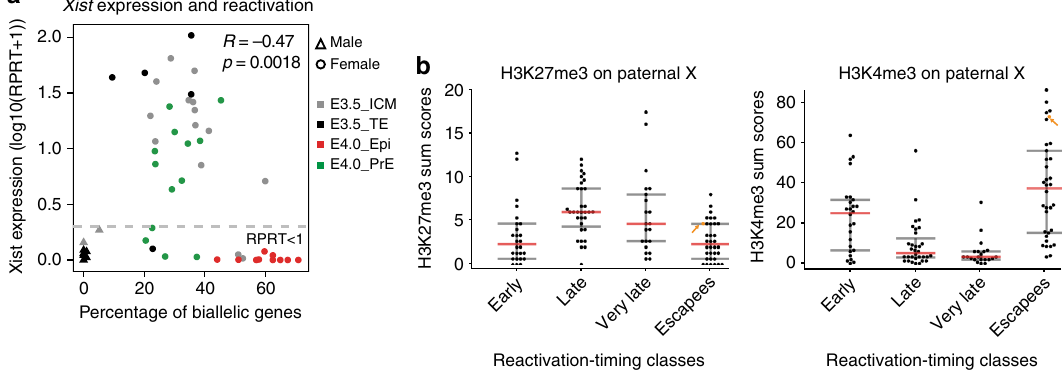
Fig. 5 Link between Xist expression, epigenetic landscapes and Xp reactivation. a Anti-correlation is shown between the level of Xist expression and the number of biallelically/reactivated and informative X-linked genes in scRNAseq (Spearman correlation). Male E3.5 single cells have been added and used as control for Xist expression and X-linked gene parental expression. Genes with level of expression as (RPRT < 1) are considered as non-expressed in our samples. b Enrichment of H3K27me3 and H3K4me3 on paternal X-chromosome obtained from Zheng et al. 38 shows signi fi cant differences (by Wilcoxon test) between early and escapee reactivation-timing classes compared to late and very late. Low cell chromatin immunoprecipitation sequencing (ChIPseq) have been performed with ICM cells of pre-implantation embryos (pooled between E3.5 – E4.0) after immunosurgery of the ICM 38 . Activated genes show an excess of H3K4me3 and repressed ones an enrichment of H3K27me3. Xist is highlighted with an orange arrow. Early vs. late ( p = 2.29 × 10 − 4 for H3K27me3 and p = 1.63 × 10 − 3 for H3K4me3) and very late ( p = 2.51 × 10 − 2 for H3K27me3 and p = 3.95 × 10 − 4 for H3K4me3) and escapees vs. late ( p